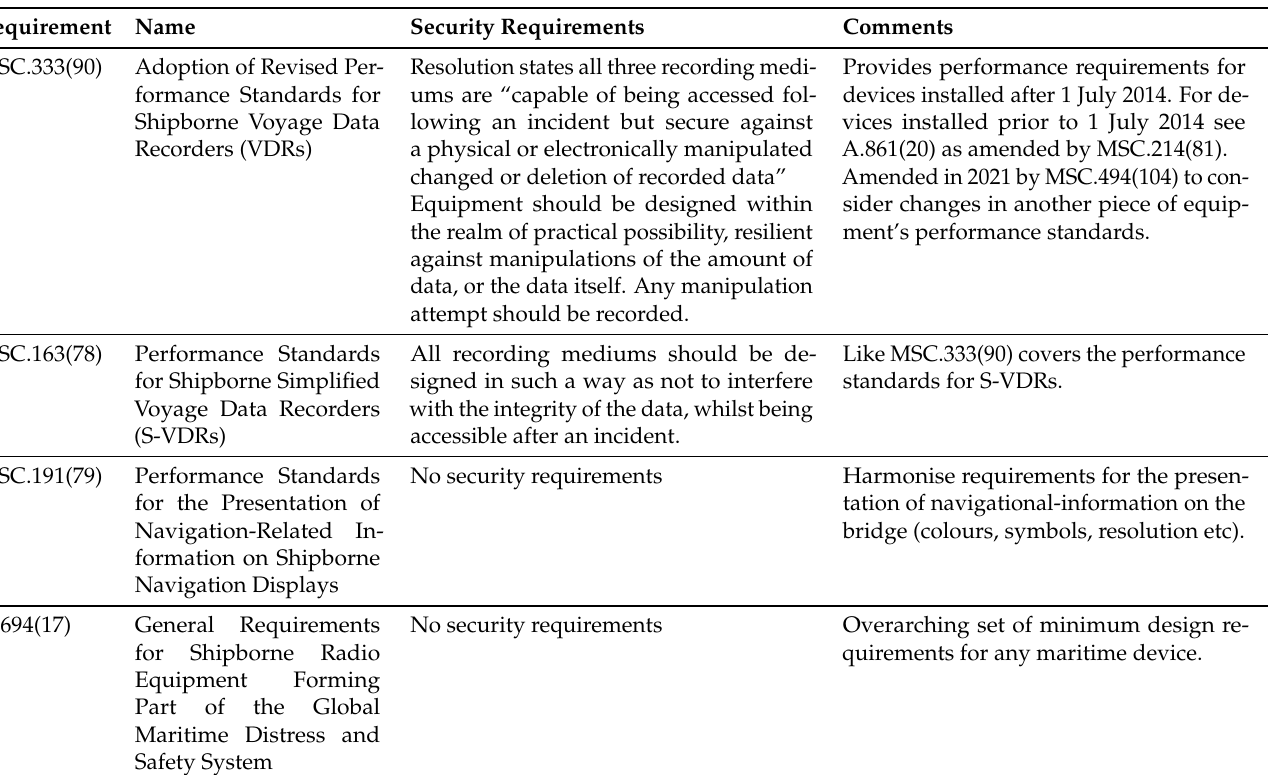
Table 2. Summary of IMO Requirements for